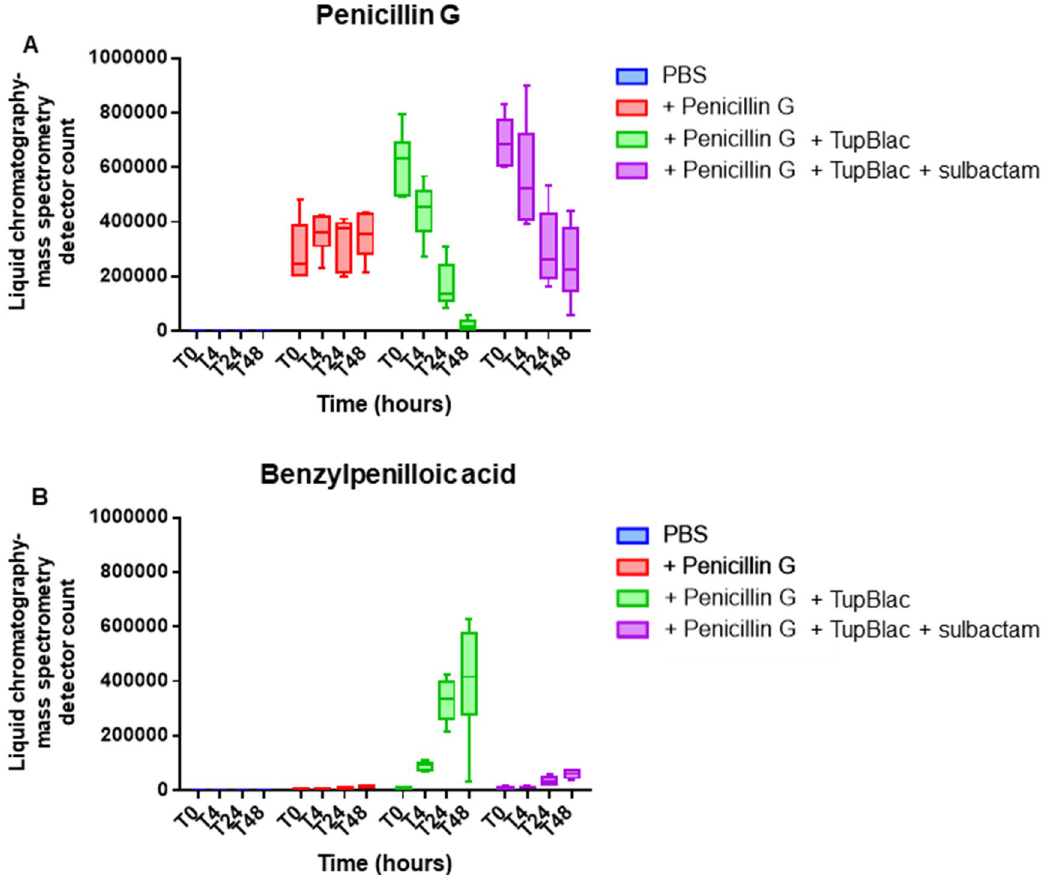
Figure 3. Effect on penicillin G of expressed Tupanvirus protein (TupBlac). The effect on penicillin G of the expressed Tupanvirus protein (TupBlac) and its inhibition by sulbactam were assessed by monitoring